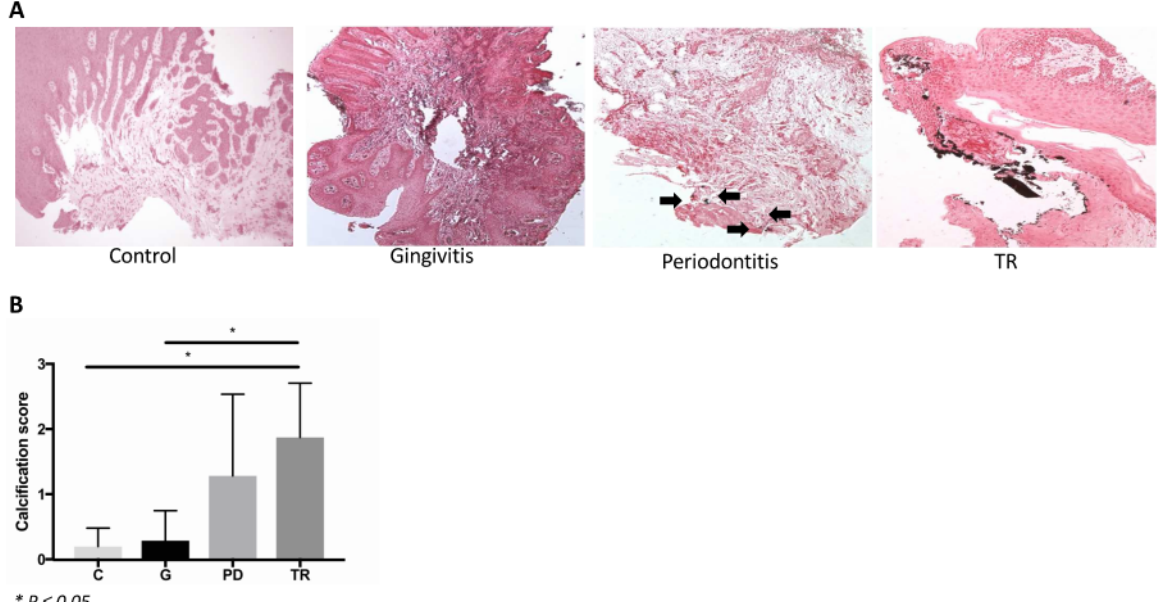
Figure 1. ( A ) Von Kossa staining of the gingiva in control cats (C) ( n = 4) and cats affected by gingivitis (G) ( n = 6), periodontitis (PD) ( n = 8) or tooth resorption (TR) ( n = 11). Images were obtained at 100 × magnification. In control and gingivitis sections, no crystals were observed (calcification score 0). In periodontitis samples, rare, tiny crystals, marked by black arrows, were present (calcification score 1). In this TR section many large crystals could be seen (calcification score 3). ( B ) There was a significant increase in the occurrence of crystals in the tooth resorption (TR) ( n = 11) group compared with the control (C) ( n = 4) and gingivitis (G) ( n = 6) groups (both p ≤ 0.05). There was no significant difference between the periodontitis group (PD) ( n = 8) and the other groups.